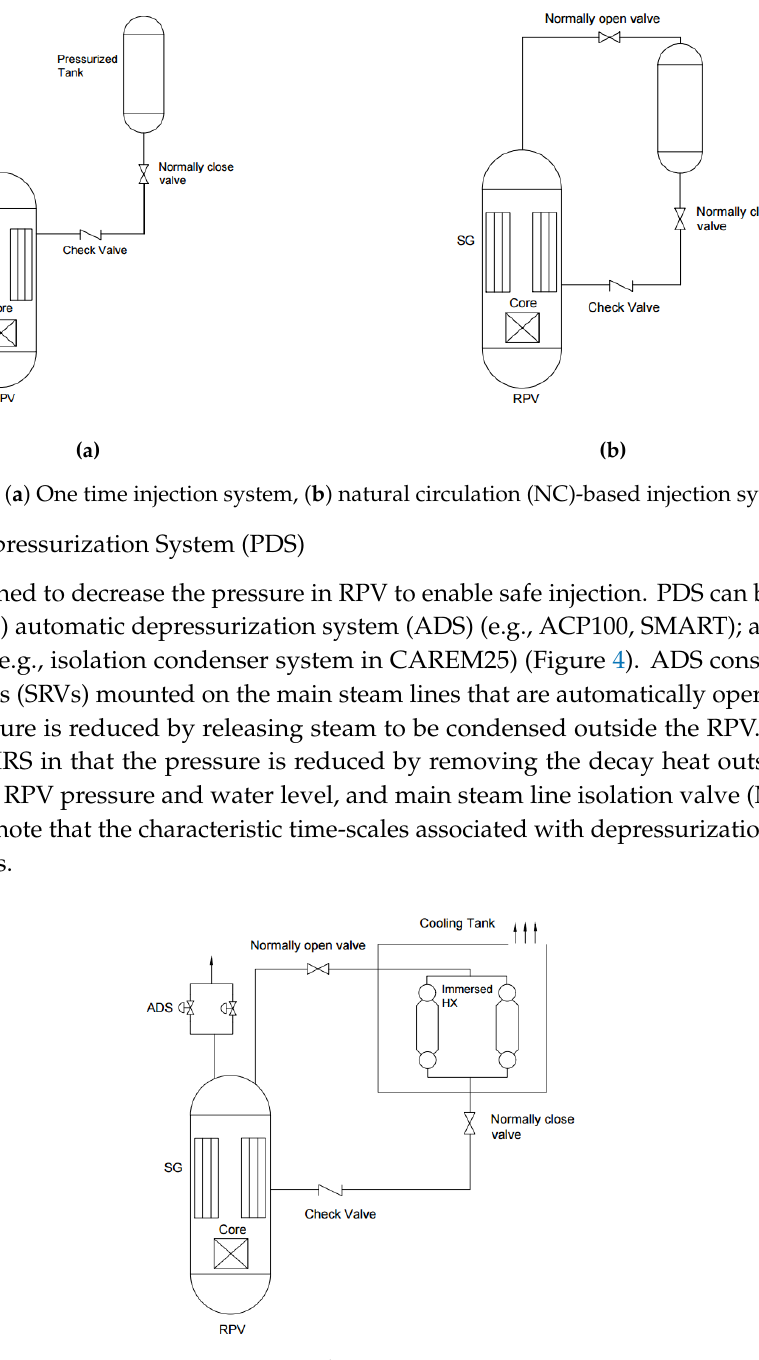
Figure 4. Passive depressurization systems .